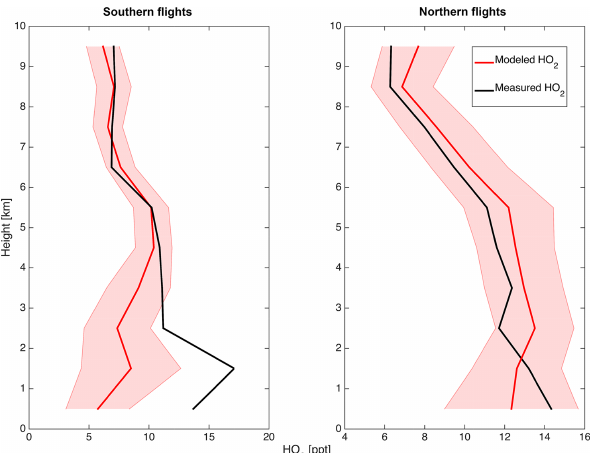
Figure 10. Modeled and measured HO 2 profiles for ARCTAS-B flights. Shaded region represents 1 σ of model ensemble. Left rep- resents flights 17, 18, 19, 20, and 21. Right represents flights 22 and